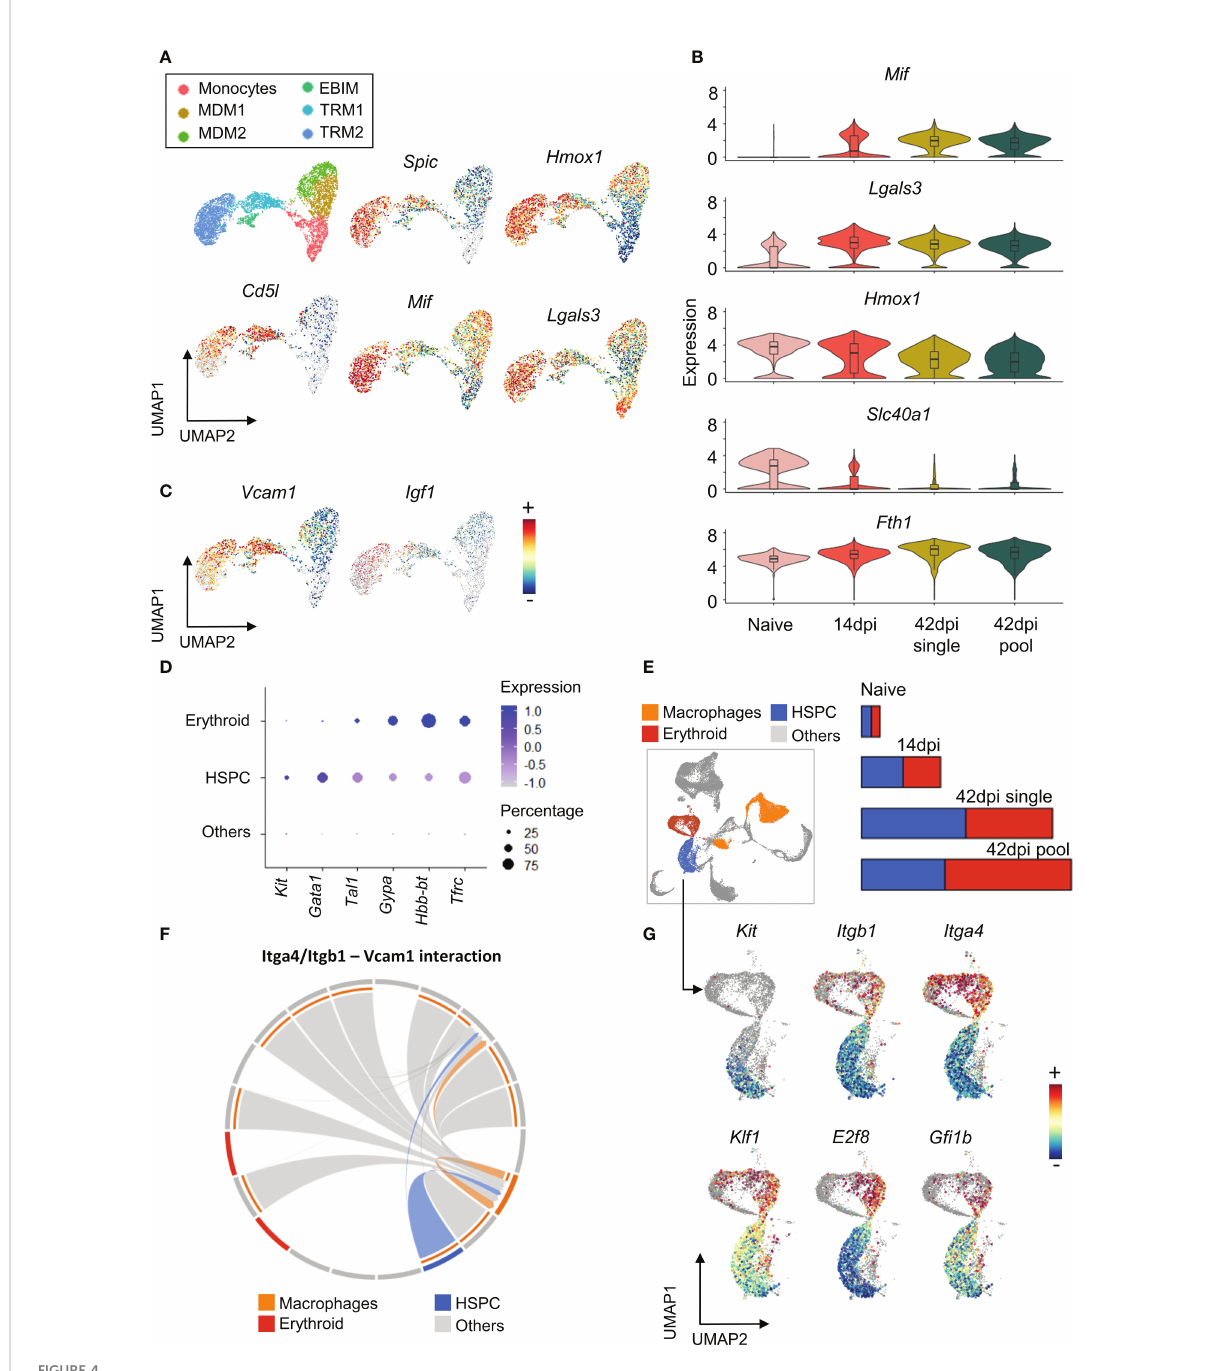
FIGURE 4 Tissue resident macrophages show multi potential roles during chronic T. evansi infection. (A) UMAP showing macrophages sub-population ( fi rst panel) and log-normalized expression of genes expressed by Tissue resident macrophages (B) Changes in expression of genes related to iron retention during infection. (C) UMAP showing expression of Vcamp1 and Igf1 genes. (D) Average expression of gene markers used for HSPCs and Erythroid annotation. (E) UMAP projection of Macrophages, HSPCs, and Erythroid populations on combined total spleen cells dataset and their cell number alteration during infection. (F) Chord diagram of the inferred Itga4/Itgb1 – Vcam1 interaction among cell populations. (G) Log-normalized expression of genes involved in Hematopoiesis and Erythropoiesis on HSPCs and Erythroid